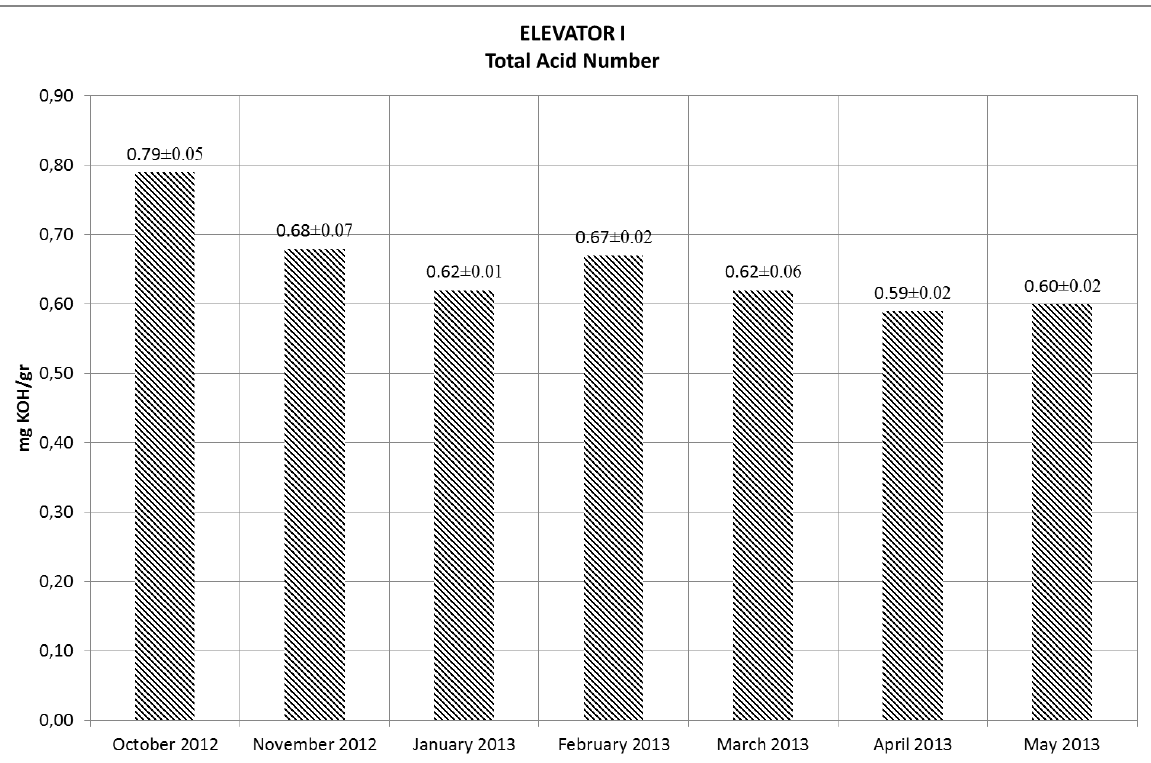
Figure 5. Total Acid Number of Elevator